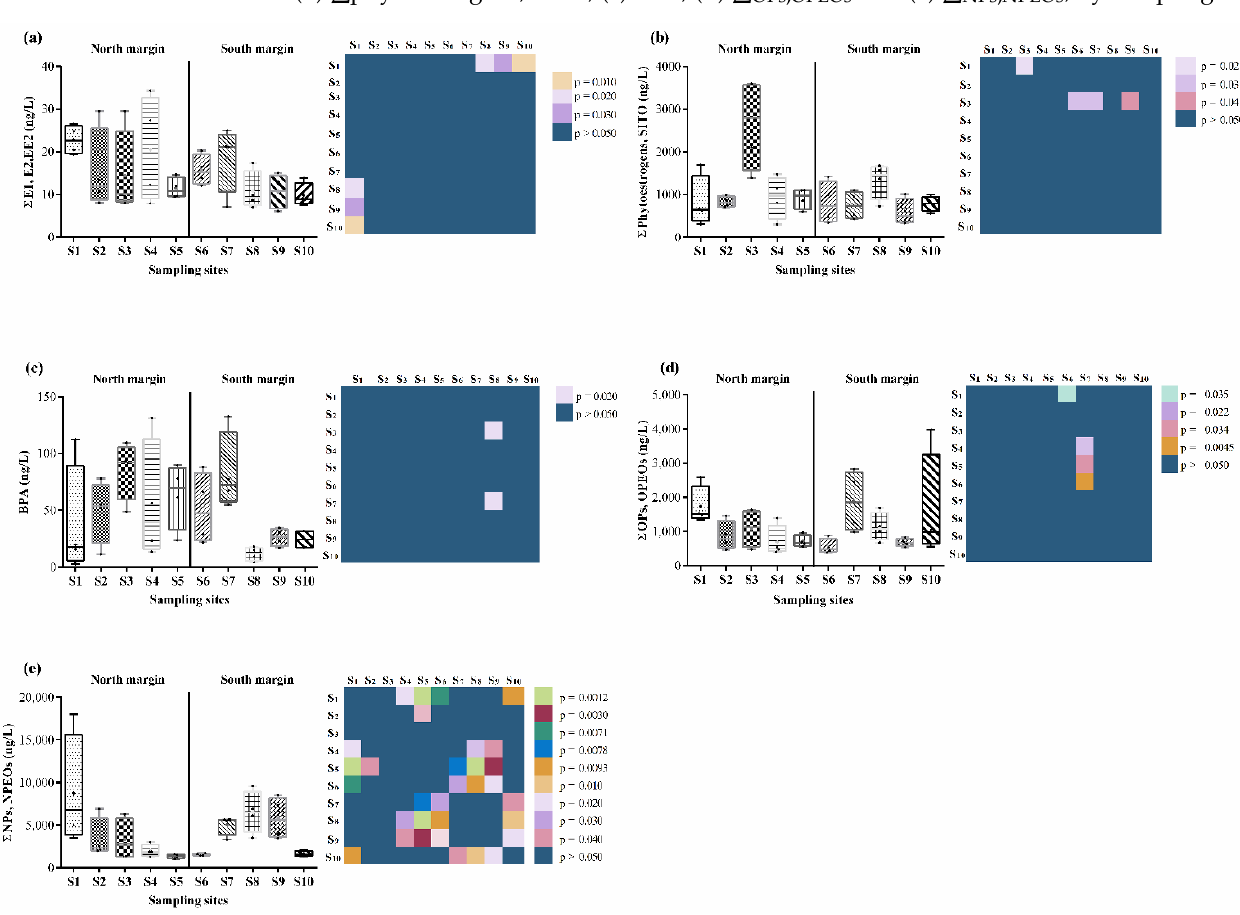
Figure 3. Levels (ng/L) of: ( a ) ∑ oestrogens; ( b ) ∑ phytoestrogens and SITO; ( c ) BPA; ( d ) ∑ OPs and OPEOs; ( e ) ∑NPs and NPEOs per sampling site (n = 4). Data are expressed in boxplots with the minimum, median, maximum, average (+), and interquartile range Q1–Q3. Dots represent average individual values measured in different sampling occasions. Significant differences are reported in the colour chart.